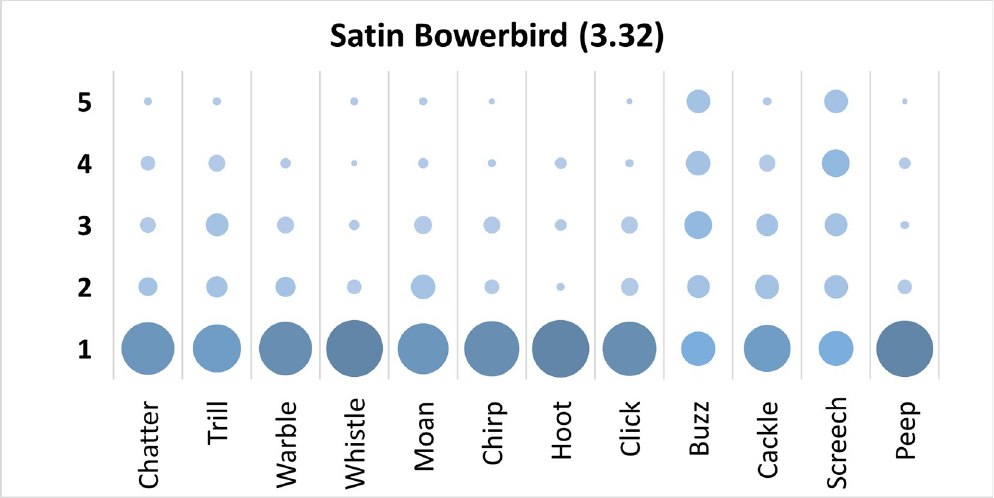
Fig 8. Count of participants’ sound descriptions scores for the Satin Bowerbird with confidence ratings in brackets.